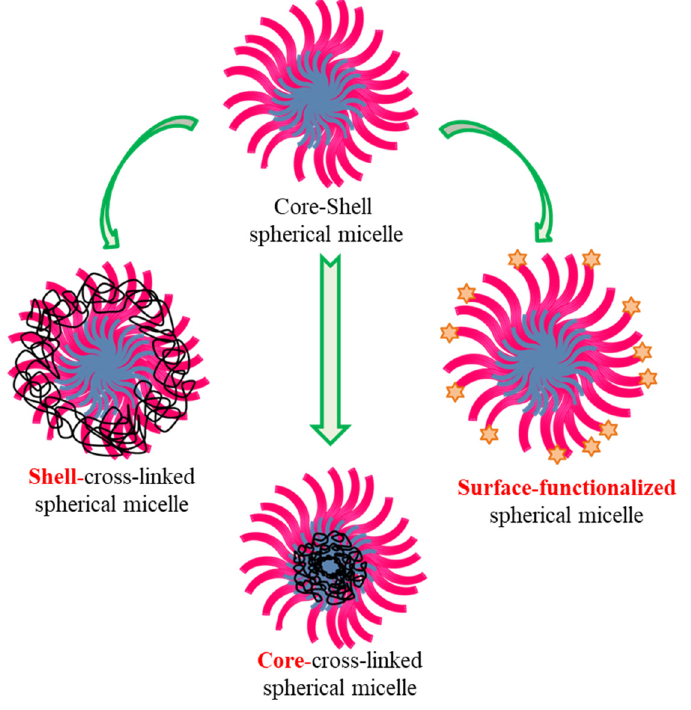
Figure 8. Alteration in the polymeric micelles via cross-linking of core-, shell- and surface- functionalization.